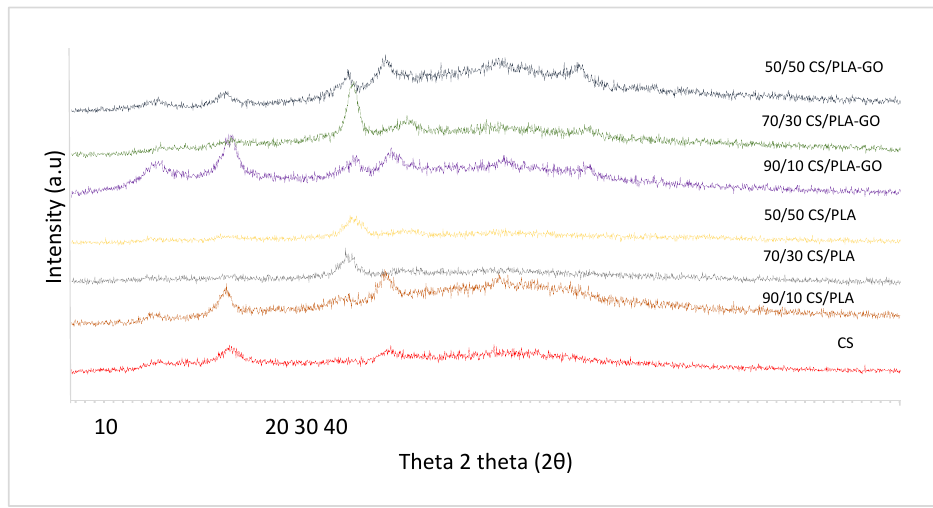
Figure 3. XRD patterns of CS and CS/PLA with and without GO composites. The XRD pattern of 90/10CS/PLA shows the crystalline peak at 11.7 ◦ and 18.3 ◦ corresponding to the peak in CS. On the other hand, XRD patterns of 70/30CS/PLA and 50/50CS/PLA peak at 16.88 ◦ and 16.96 ◦ , respectively. The crystalline peak around 16.78 ◦ was corresponding to a broad diffraction peak of PLA [31,32]. For both 70/30CS/PLA and 50/50CS/PLA composites, the peaks of CS did not appear in their XRD pattern. Diffraction peaks disappeared in composites, indicating that intercalation or exfoliation structures have been formed.